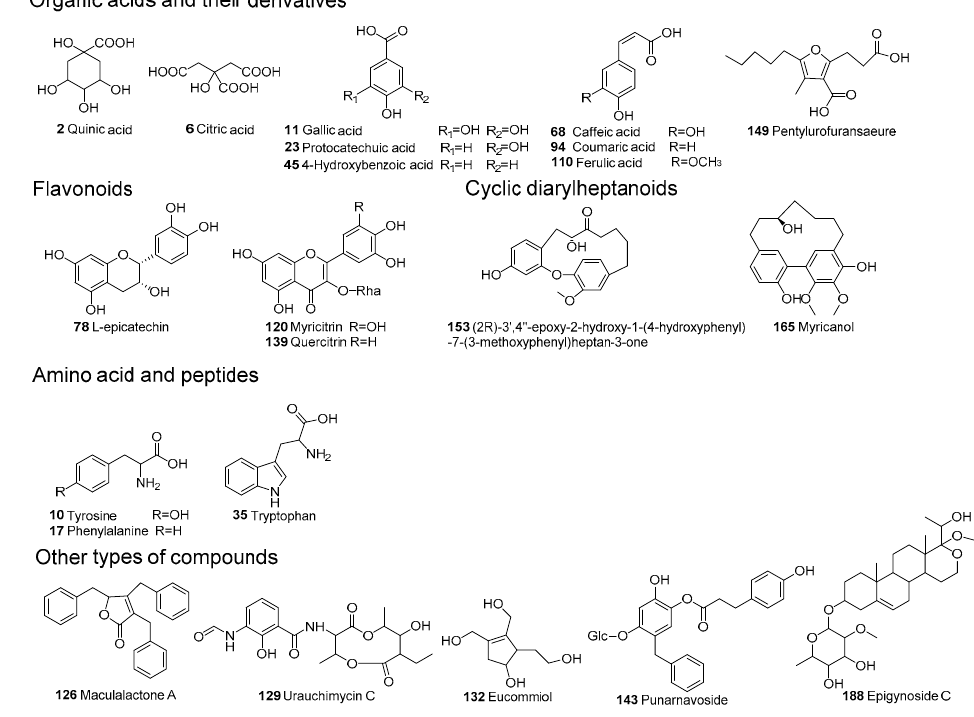
Figure 3. Chemical structures of some constituents identified in the extract of Myrica rubra.